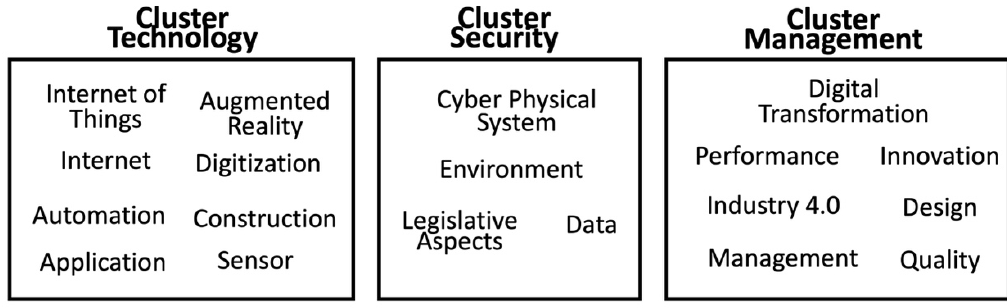
Figure 4. Clustering of the keywords (Source Author’s illustration). Table 9. Clustered topics discussed in 20 targeted papers